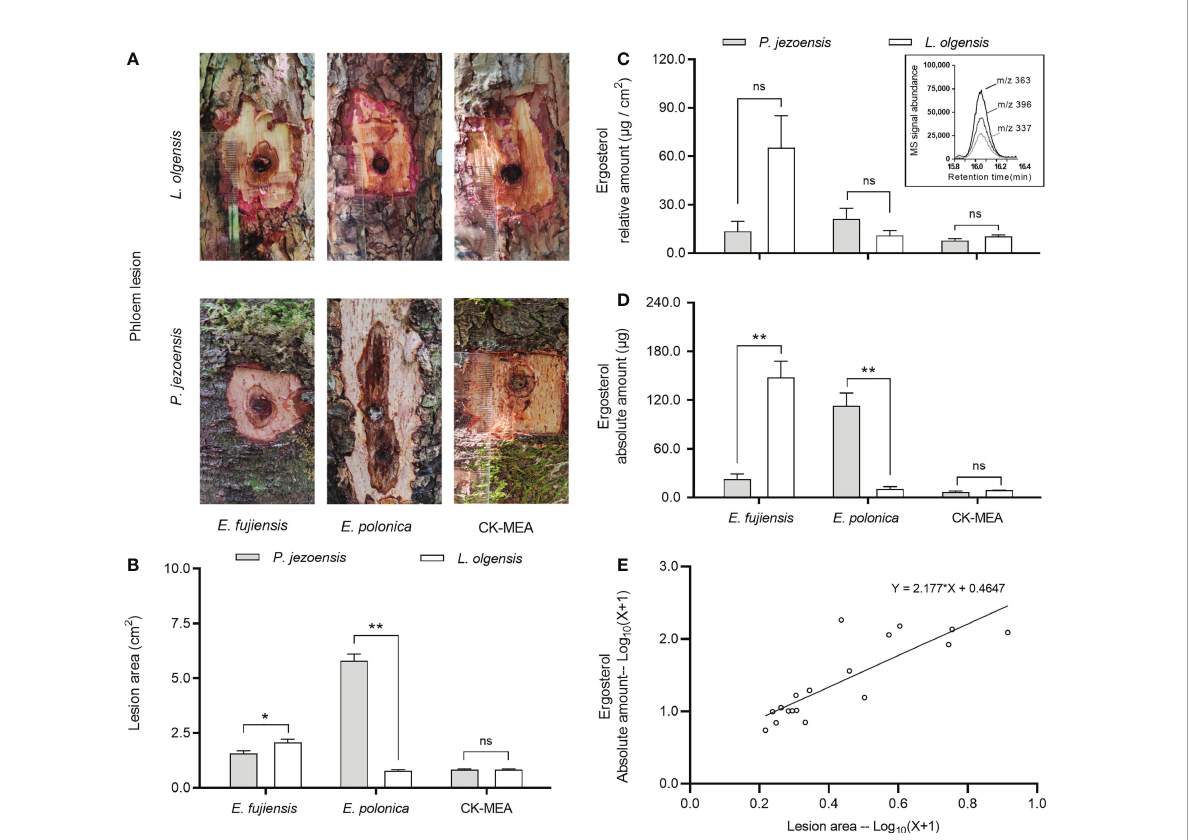
FIGURE 2 Mean ( ± SE) lesion areas and ergosterol on P. jezoensis and L. olgensis in response to culture inoculations. (A) Phloem lesion area of E. fujiensis , E. polonica , and MEA on P. jezoensis and L. olgensis , respectively; (B) lesion area, (C) relative amount of ergosterol and (D) absolute amount of E. fujiensis , E. polonica , and MEA on P. jezoensis and L. olgensis , respectively; (E) linear regression analysis between lesion area and absolute amount of ergosterol. Inset shows ion signal abundance of selective ions (m/z 337, 363, and 396) of ergosterol. Asterisks indicate signi fi